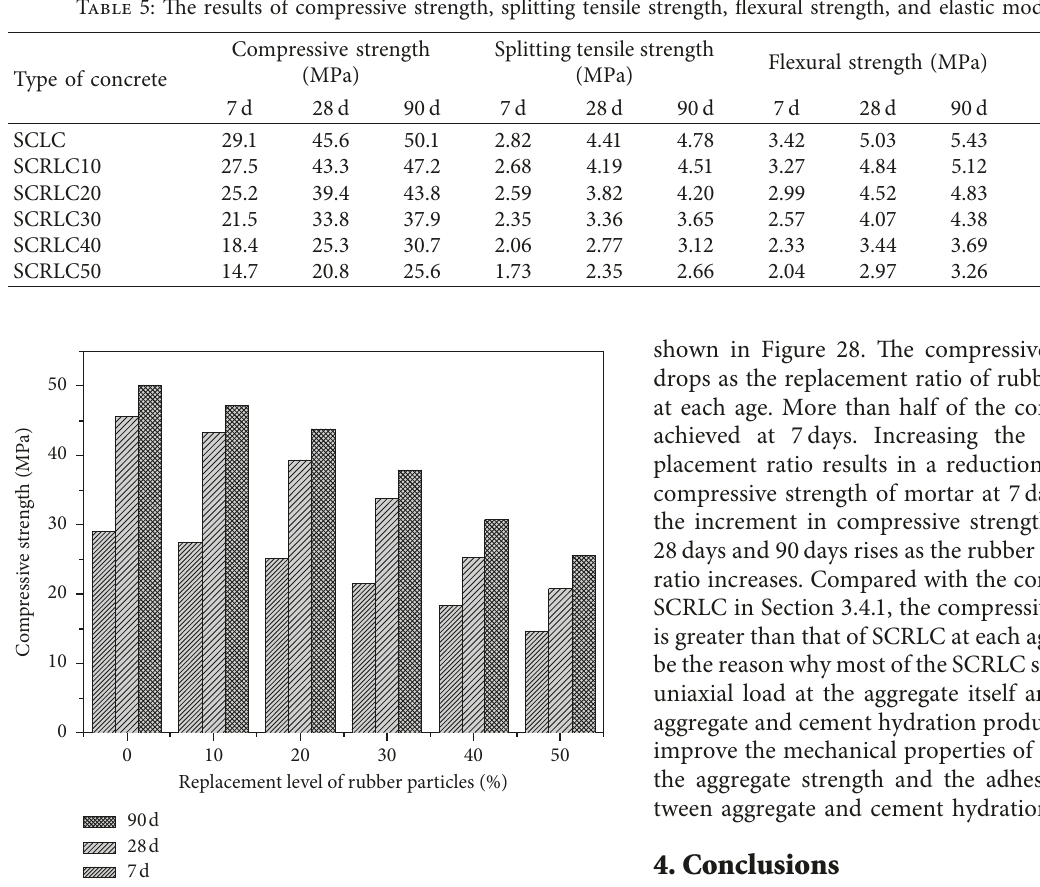
Figure 21: Compressive strength of SCRLC versus replacement level of rubber particles.